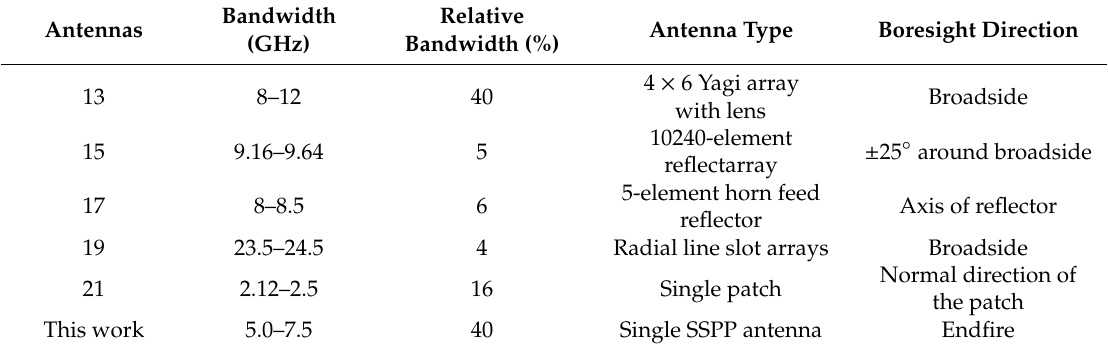
Table 2. Performance of the proposed monopulse antennas and other antennas.